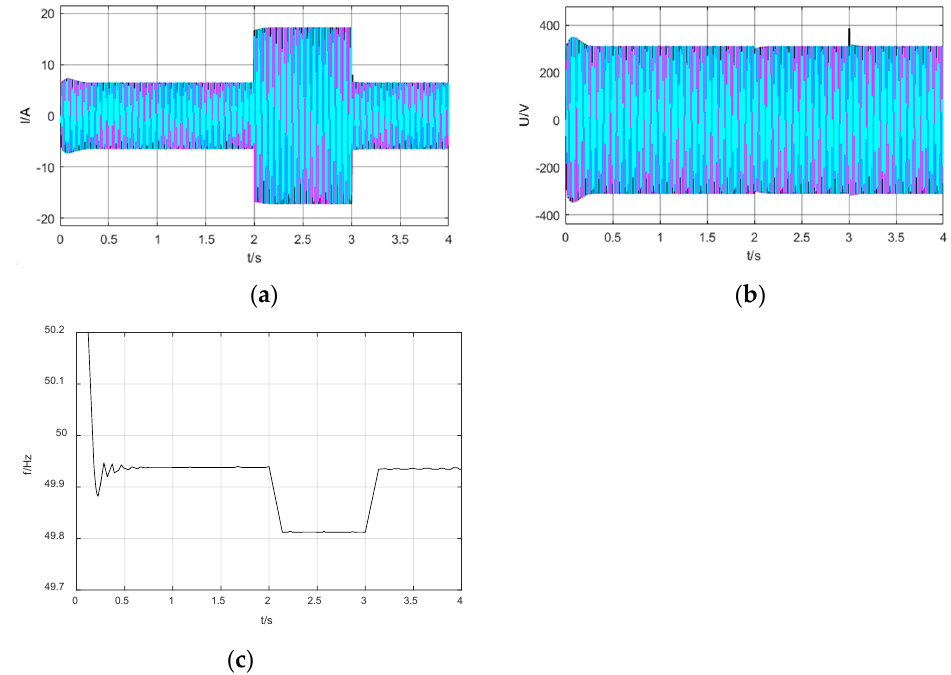
Figure 17. Simulation result of control system. ( a ) Current waveform; ( b ) Voltage waveform; ( c ) System frequency.